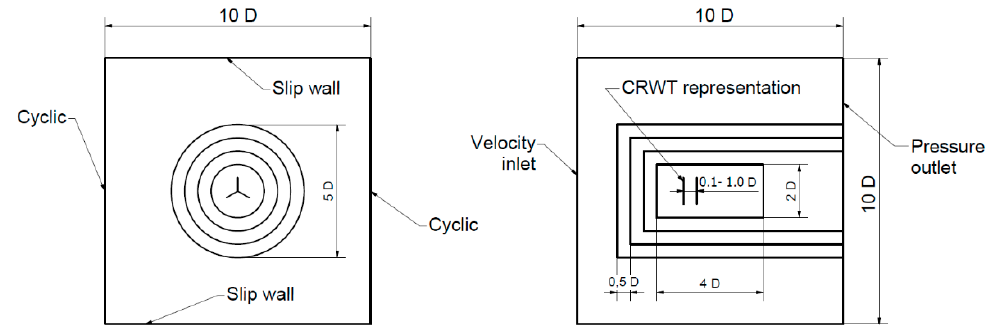
Figure 2. Computational domain with applied boundary conditions.